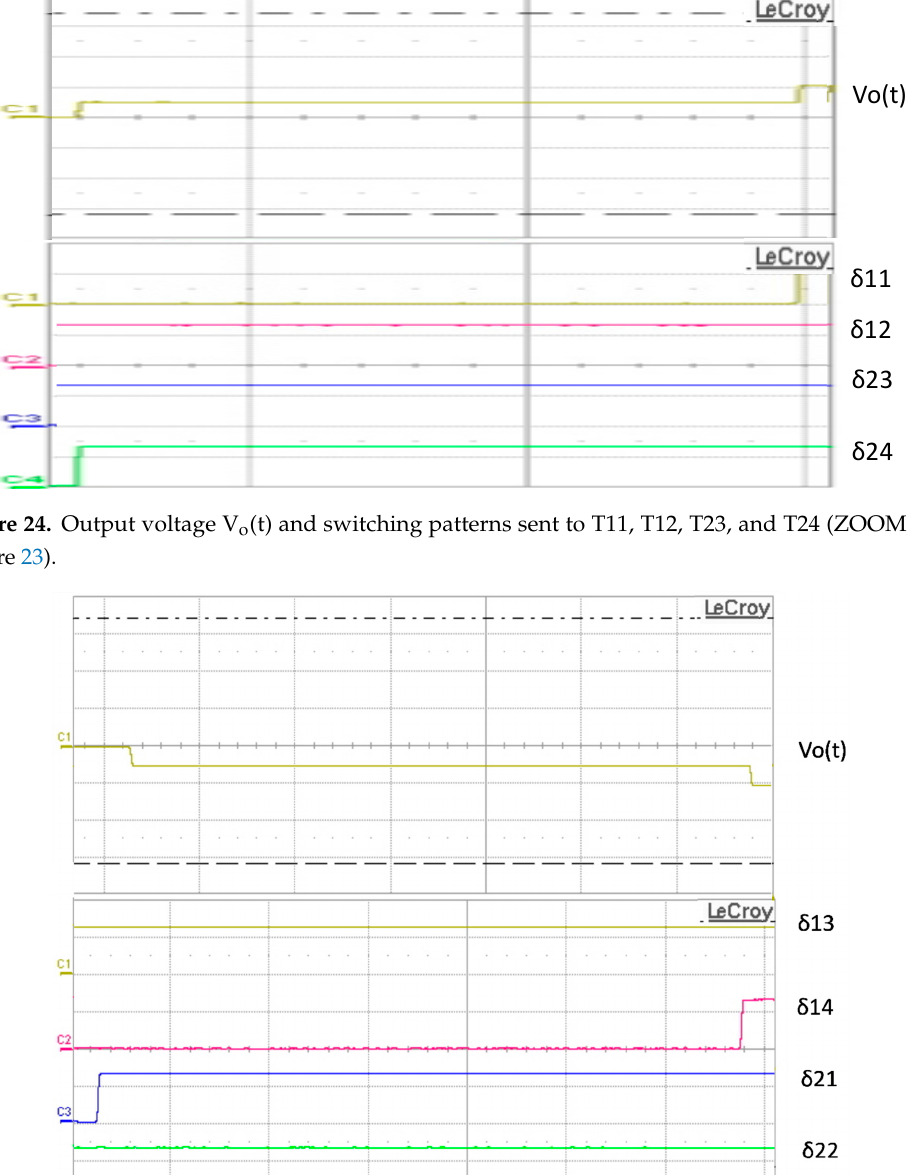
Figure 25. Output voltage V o (t) and switching patterns sent to T13, T14, T21, and T22 (ZOOM 2 of Figure 23).